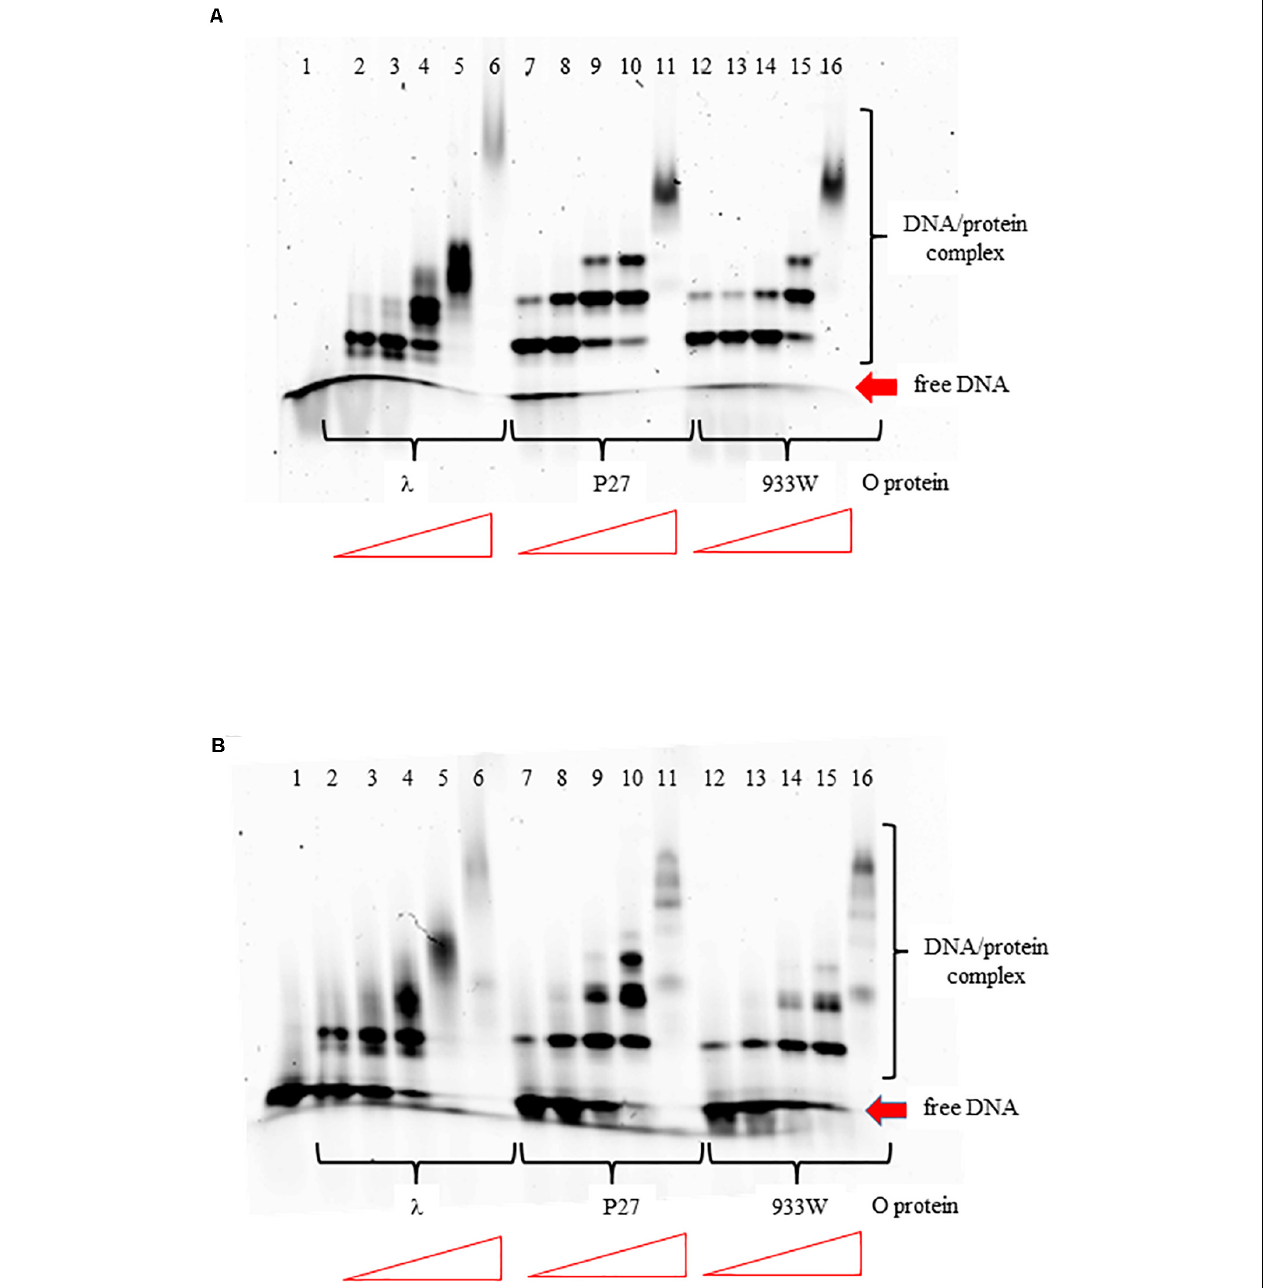
FIGURE 2 | Interactions of O proteins of phages λ , P27 and 933W with DNA templates containing four panel (A) or six panel (B) iterons, as assessed by EMSA. Increasing molar ratios of DNA:O proteins, indicated in particular wells, were as follows: 1:2, 1:4, 1:8, 1:16, and 1:32. Lane no. 1 contains no O